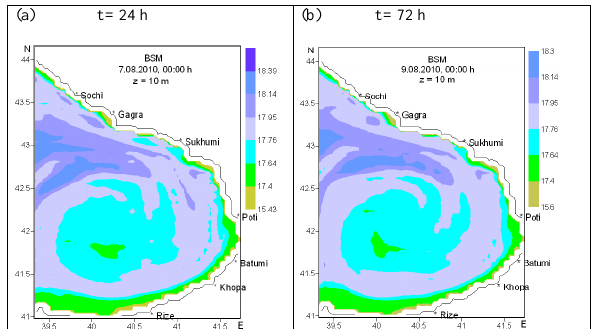
Fig. 8. The salinity fields (psu) on depth of 10 m predicted by RM-IG at 24 h (a) and 72 h (b) (the forecasting period is 6.08.2010, 00:00 h –9.08.2010, 00:00 h).